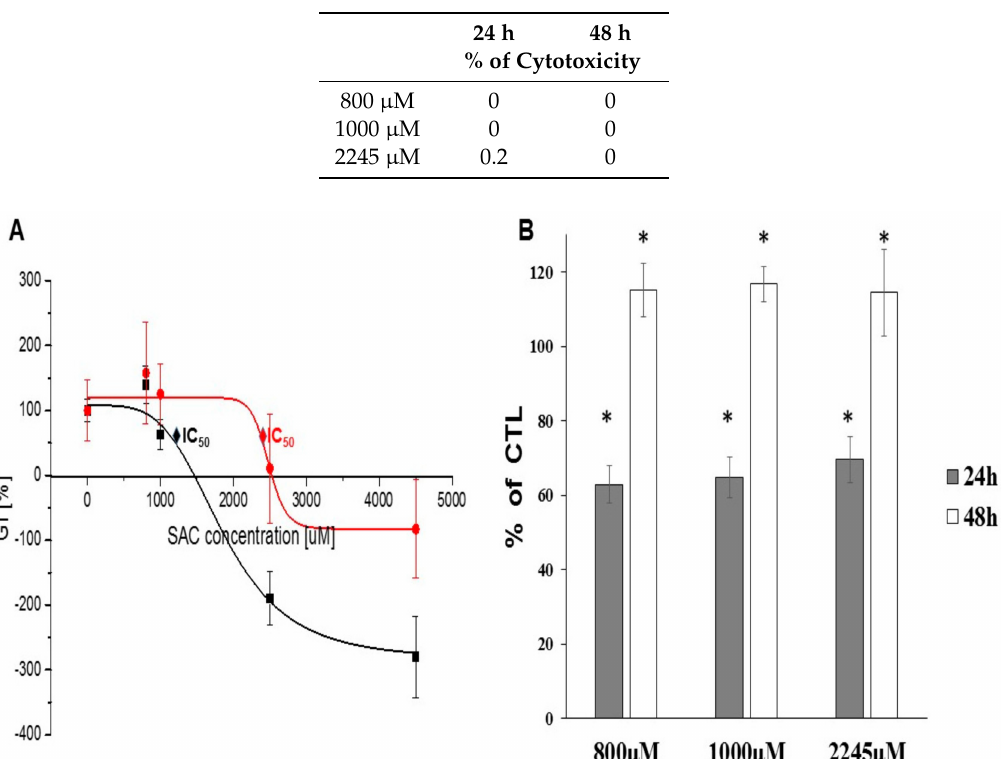
Figure 1B. The exposure of MCF-7 cells to SAC resulted in a significant dose-dependent suppression of viability compared to the control cultures. Autocrine growth of the investigated cells, determined by MTT assay, was almost completely inhibited at the SAC concentration ≥ 2500 µ M after 24 and 48 h. A 50% inhibition of the growth of MCF-7 cells was determined by fitting a sigmoidal model of the dose-dependent e ff ect of the investigated compound. IC 50 coe ffi cients calculated from the growth inhibition curves (Figure 1A) after 24 and 48 h of incubation were 1185.45 ± 10.93 µ M for 24 h and 2382.29 ± 43.69 µ M for 48 h, respectively. A significant decrease ( p < 0.05 for 800 µ M, 1000 µ M and 2245 µ M SAC vs. control) in the cell viability around 40% in relation to the control was observed at 800 µ M, 1000 µ M and 2245 µ M SAC concentrations after 24 h incubation, as measured by MTT assay (Figure 1B). Table 1. The cytotoxicity e ff ect of S-Allyl-L-cysteine (SAC) in concentrations 800 µ M, 1000 µ M and 2245 µ M in the human breast adenocarcinoma cell line MCF-7 after 24 h and 48 h incubations.